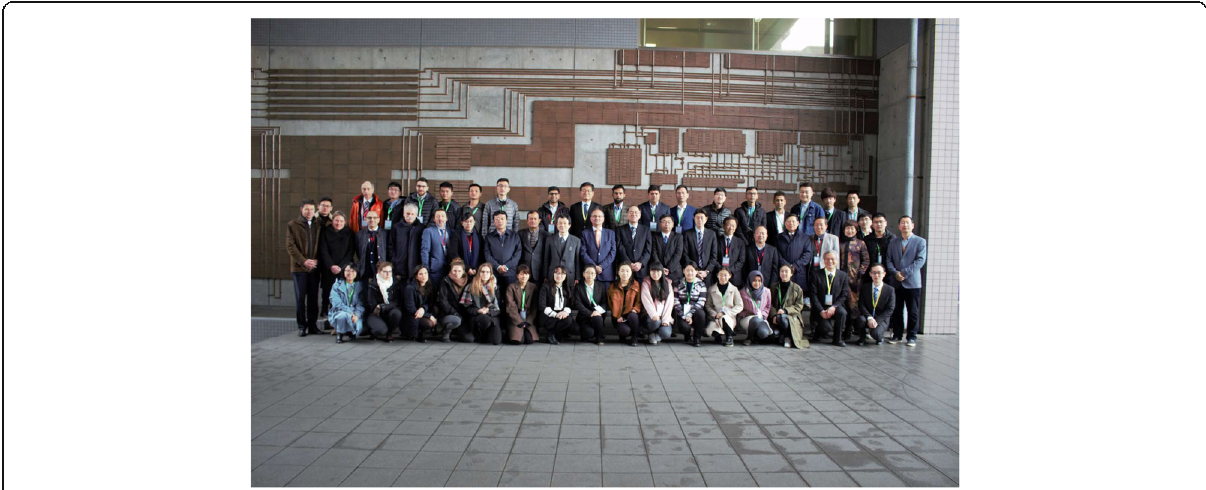
Fig. 6 Group photo of the participates of the UNESCO Chair 2019 Field School on Geoenvironmental Disaster Reduction